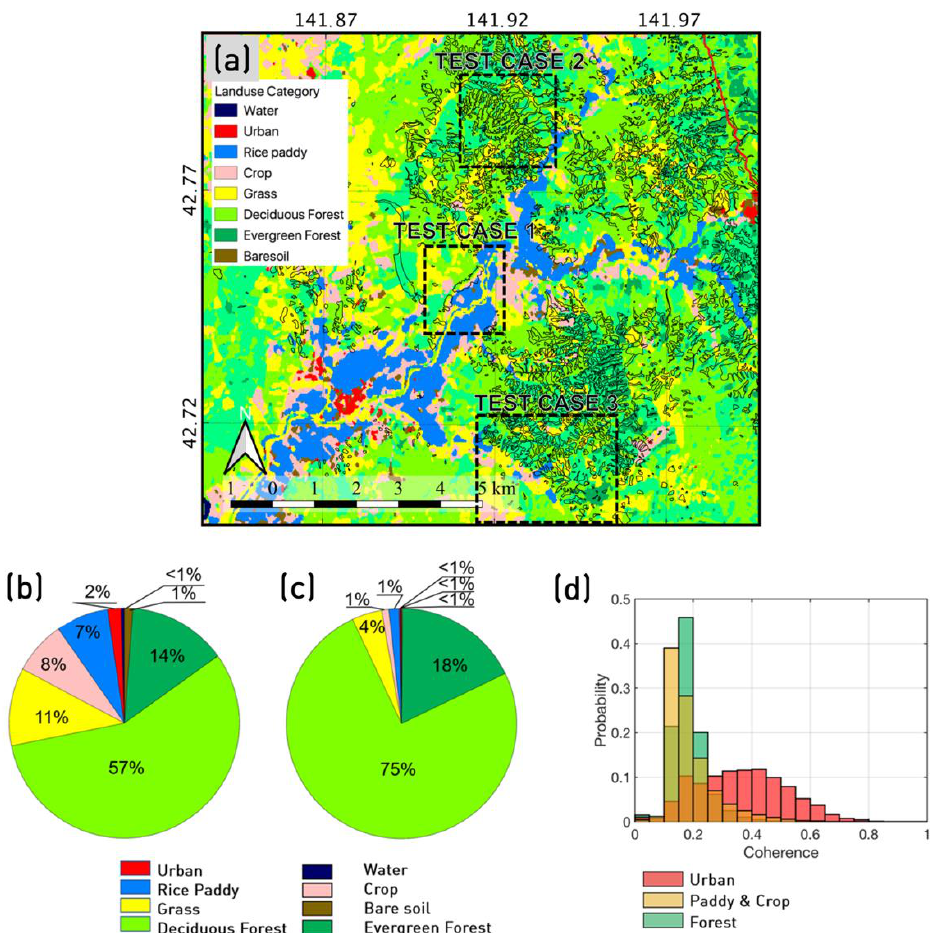
Figure 5. ( a ) Land use map provided by Japan Aerospace Exploration Agency (JAXA) (https://www.eorc.jaxa.jp/ALOS/lulc/lulc_jindex.htm). Black polygons represent landslide areas manually extected from aerial photo (Figure 1 a ). Pie charts showing the portions of each land use for ( b ) the whole study area and ( c ) the landslide area. ( d ) Histogram of the averaged coherences for urban, agricultural area, and forest.